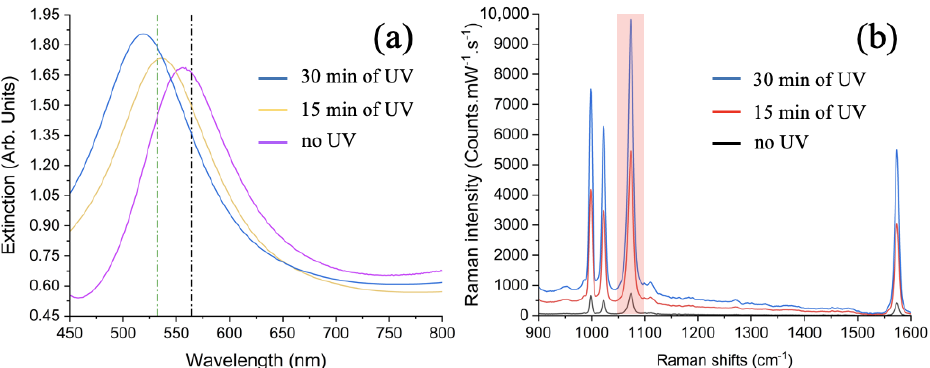
Figure 2. ( a ) Extinction spectra of Au nanoparticles on ZnO film without UV-irradiation (in purple color), with an UV-irradiation of 15 min (in dark yellow color) and 30 min (in blue color). The green and black dashed lines correspond to the excitation wavelength and the wavelength of the Raman emission for the chosen vibration mode (at 1073 cm − 1 ), respectively. ( b ) Raman spectra of thiophenol on these Au nanoparticles coated ZnO film recorded at the concentrations of 1 mM. For ( b ), the black, red, and blue spectra correspond to SERS, SERS + PIERS whose the time of UV-irradiation was 15 min, and SERS + PIERS whose the time of UV-irradiation was 30 min, respectively. The vibration mode at 1073 cm − 1 chosen for the study is encapsulated in the red